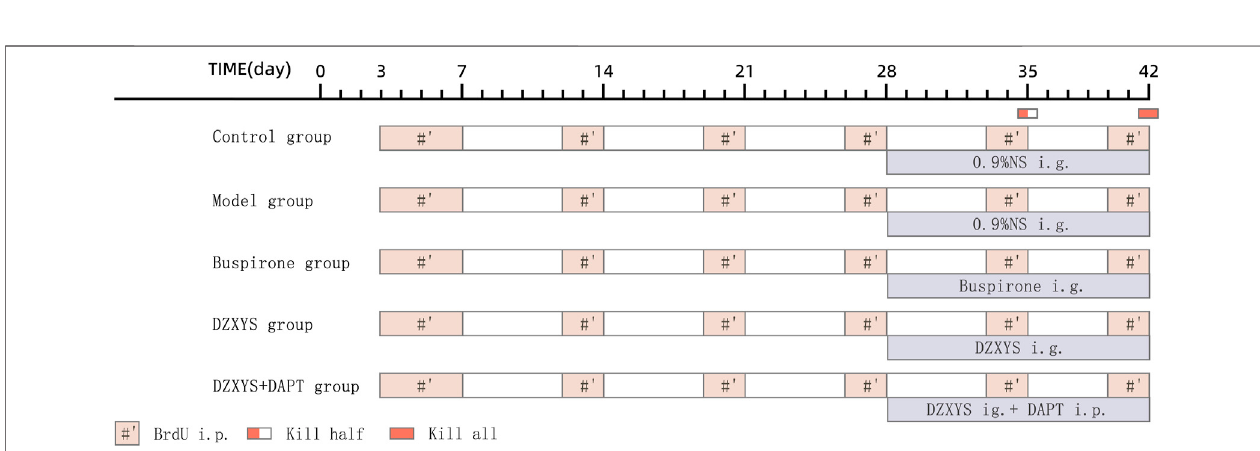
FIGURE 2 | Schedule for the drug administration. Abbreviations: i. p, intraperitoneal injection; ig, intragastric administration.